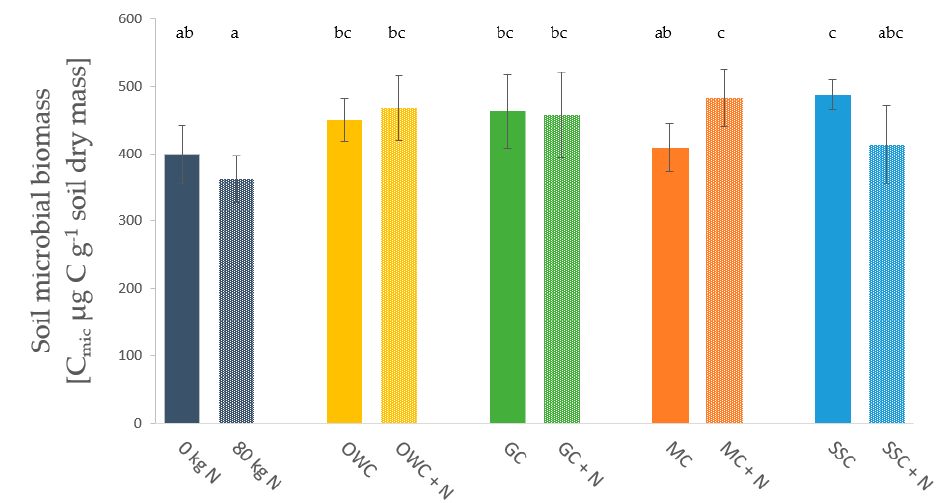
Figure 2. Soil microbial biomass (mean ± SD, n = 4). Columns with the same lowercase letters are not significantly different ( p ≤ 0.05). Control (0 kg N), 80 kg mineral N ha − 1 (80 kg N), 175 kg N ha − 1 of